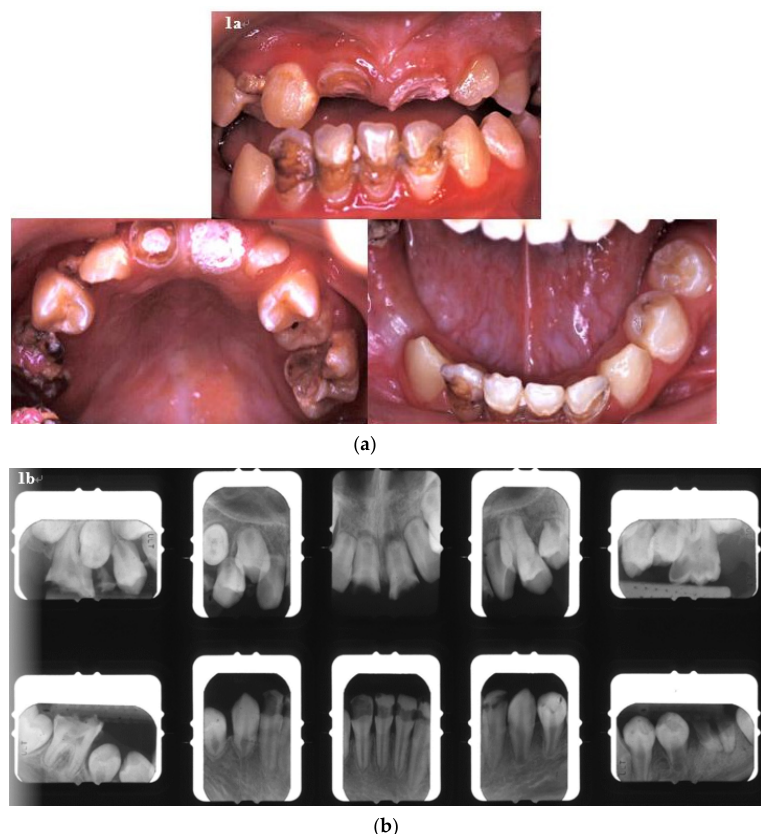
Figure 1. ( a ) There were multiple caries and residual roots, crown opacity, and hypoplastic teeth in the patient’s primary and developing permanent dentitions. ( b ) There were many deep caries with apical lesions, foreshortened and blunted roots, incomplete root development, prematurely closed root apex, and V-shaped roots in the developing dentition. The objective of the dental treatment at the time, therefore, was to preserve the exist- ing dentition for masticatory efficiency and to improve the esthetics of the patient’s teeth. Patient. The treatments performed included: extraction, banding, composite resin restora- tions, root canal fillings, and stainless steel crown fabrication. An interim denture was provided due to the poor retention of the provisional fixed restorations (Figure 2a). Six months later, following root canal fillings, all the new caries were restored, and the pro- visional prosthesis was fabricated (Figure 2b). Oral hygiene was also encouraged, in par- ticular flossing, brushing, and the application of topical fluoride, during each three-month follow-up.